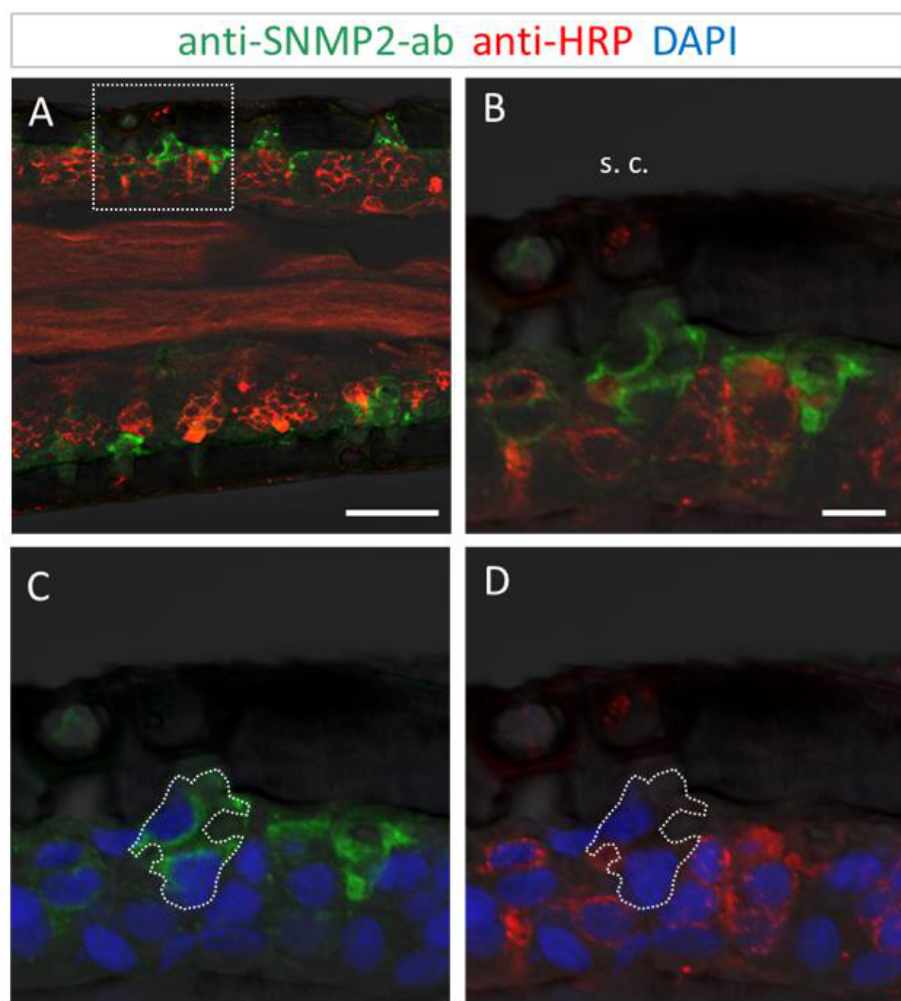
Figure 6. SNMP2 is expressed in non-neuronal cells of coeloconic sensilla in the antenna of S. gregaria . Longitudinal sections were assessed by FIHC using anti-SNMP2-ab to identify SNMP2-expressing cells (green) and anti-HRP to visualize OSNs (red); sections were stained with DAPI to visualize nuclei (blue). ( A – D ) Localization of SNMP2 in multiple non-neuronal cells. ( B – D ) Show the boxed area in ( A ) in a higher magnification. ( B ) Red and green fluorescent channels, ( C ) green and blue channels, and ( D ) red and blue channels. The encircled area denotes SNMP2-positive labelling of support cells under a coeloconic sensillum (s. c.). In all images the fluorescent channels were overlaid with the transmitted light channel. Scale bars: ( A ) = 50 µ M; ( B ) = 10 µ